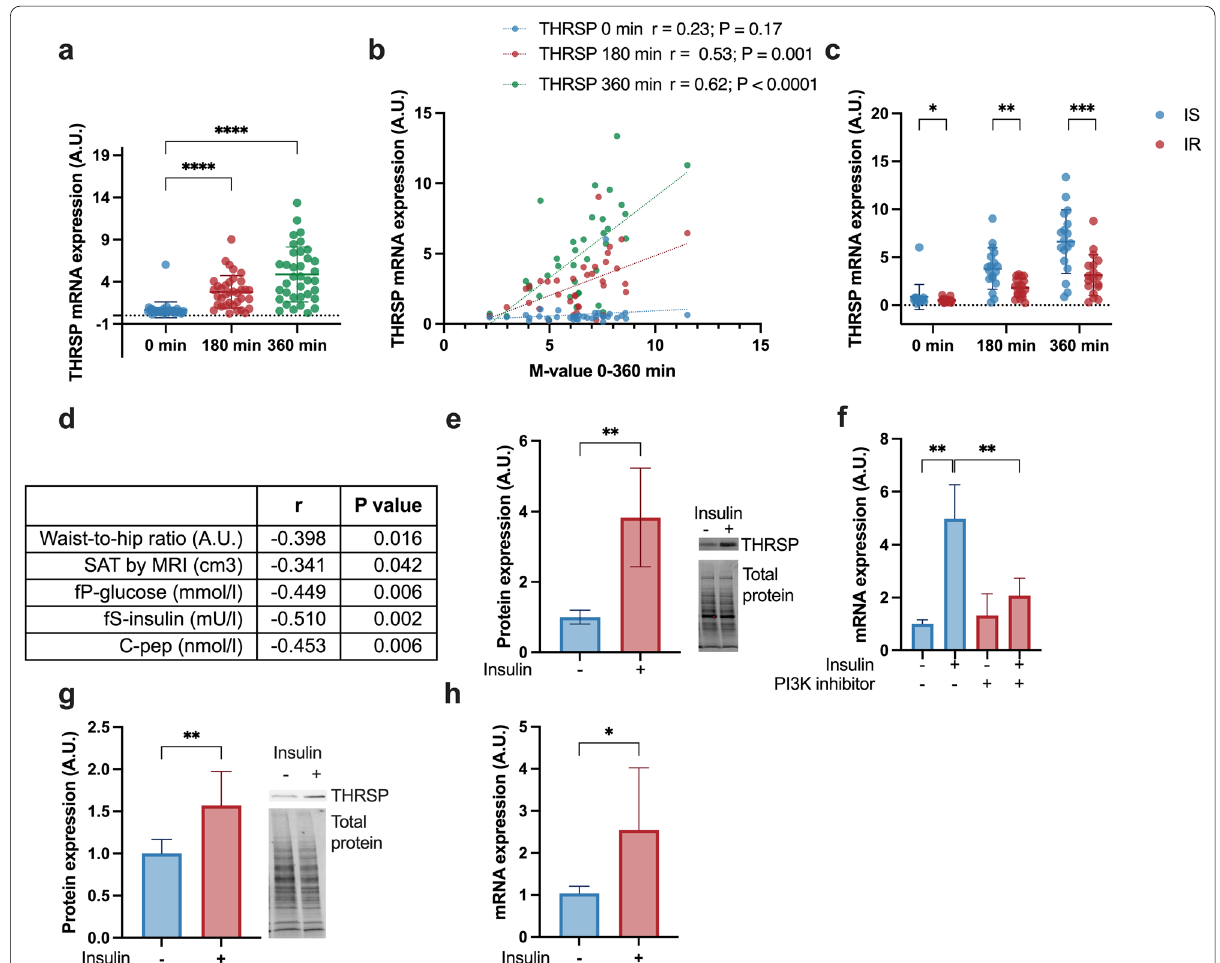
Fig. 1 Insulin induces THRSP expression in human adipose tissue and human and mouse adipocytes. a Subcutaneous adipose tissue (SAT) biopsies were obtained in a euglycemic hyperinsulinemic clamp and THRSP mRNA expression was measured at basal, 180 min and 360 min (n 36). b = THRSP expression correlated with M‑value, which is a measure of insulin sensitivity. The correlation was the strongest at 360 min. c Subjects were divided to insulin sensitive (IS; n 18) and insulin resistant (IR; n 18) group by median of M‑value. THRSP induction by insulin was higher in IS = = group in comparison to IR group. d Correlation coefficients of waist‑to‑hip ratio, amount of SAT, fasting plasma glucose (fP‑glucose), fasting serum insulin (fS‑insulin) and C‑peptide (C‑pep) e Insulin induced THRSP protein expression in SGBS adipocytes (n 6, three independent experiments). f = LY294002, an inhibitor of PI3K, blocked insulin‑mediated THRSP induction, measured at mRNA level (n 6, two independent experiments). g Insulin = induced THRSP protein expression in 3T3‑L1 adipocytes (n 10, three independent experiments). h Insulin induced THRSP mRNA expression =